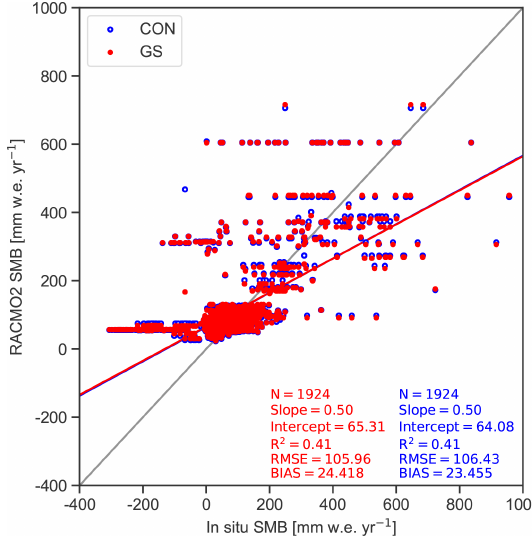
Figure A3. Yearly-accumulated SMB in the EAIS in CON and GS compared to observations. The gray line is the one-on-one line, and the red and blue lines are linear regression of the data, with the number of observations ( N ), the slope, the intercept, the correlation coefficient ( R 2 ), the bias and root-mean-square error (RMSE). The intercept, bias and RMSE are in mmw.e.yr − 1 .